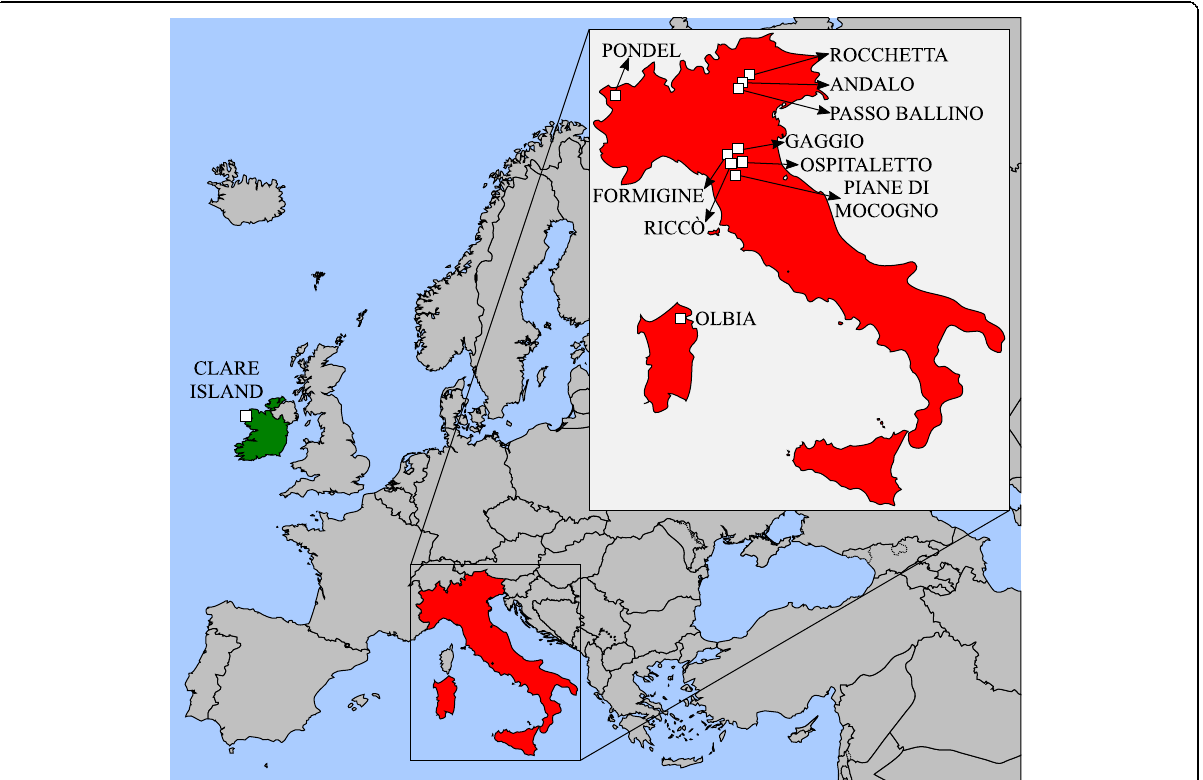
Fig. 1 Sampling localities in Ireland and